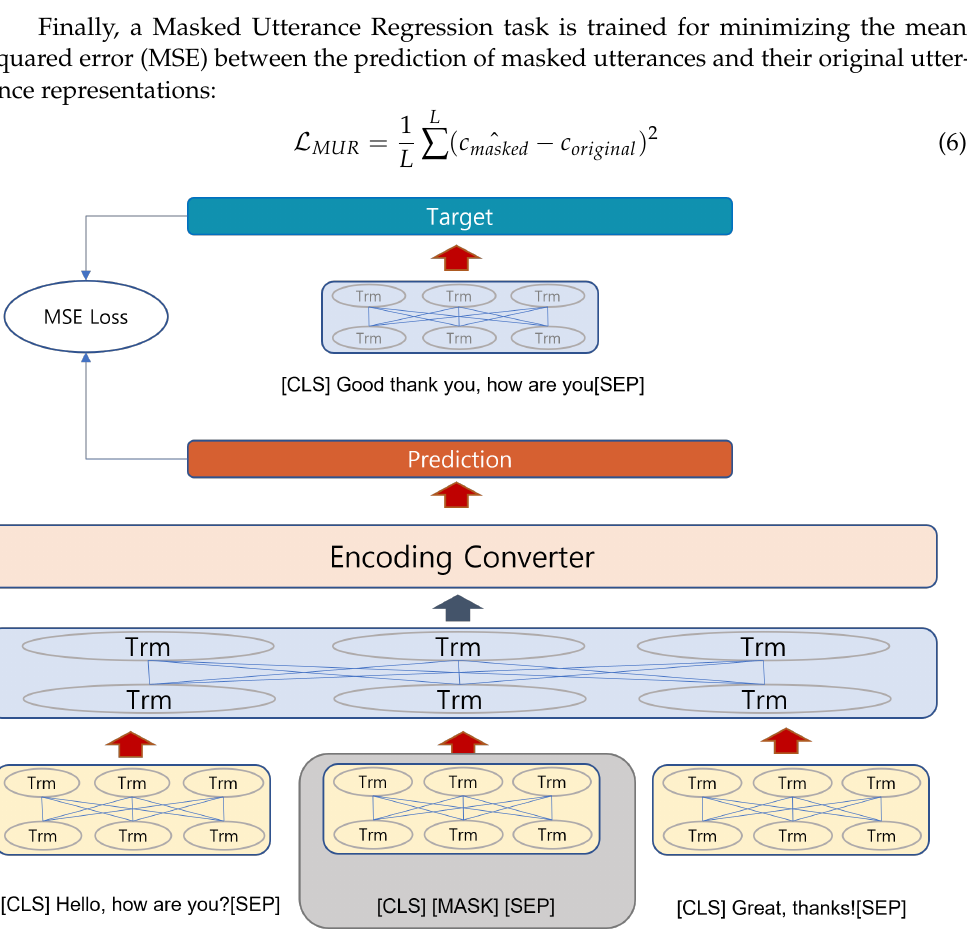
Figure 7. Overview of Masked Utterance Regression. The model estimates the masked utterance’s context-encoded representation c masked and compare the c masked with the real one produced by the utterance